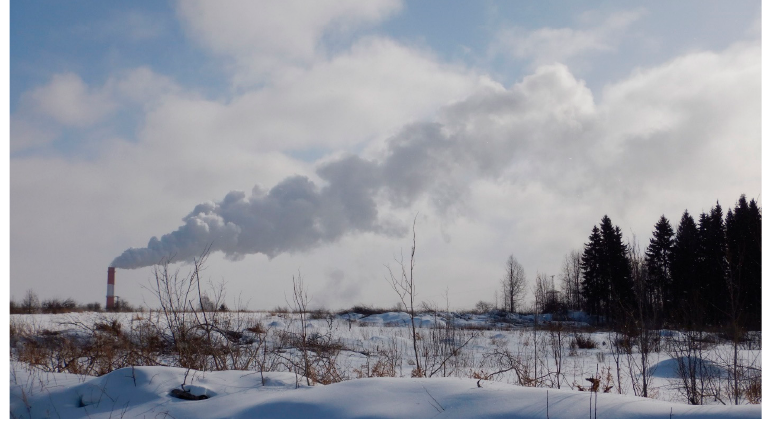
Figure 12. The view of the Petrozavodsk thermal power plant (the Republic of Karelia).